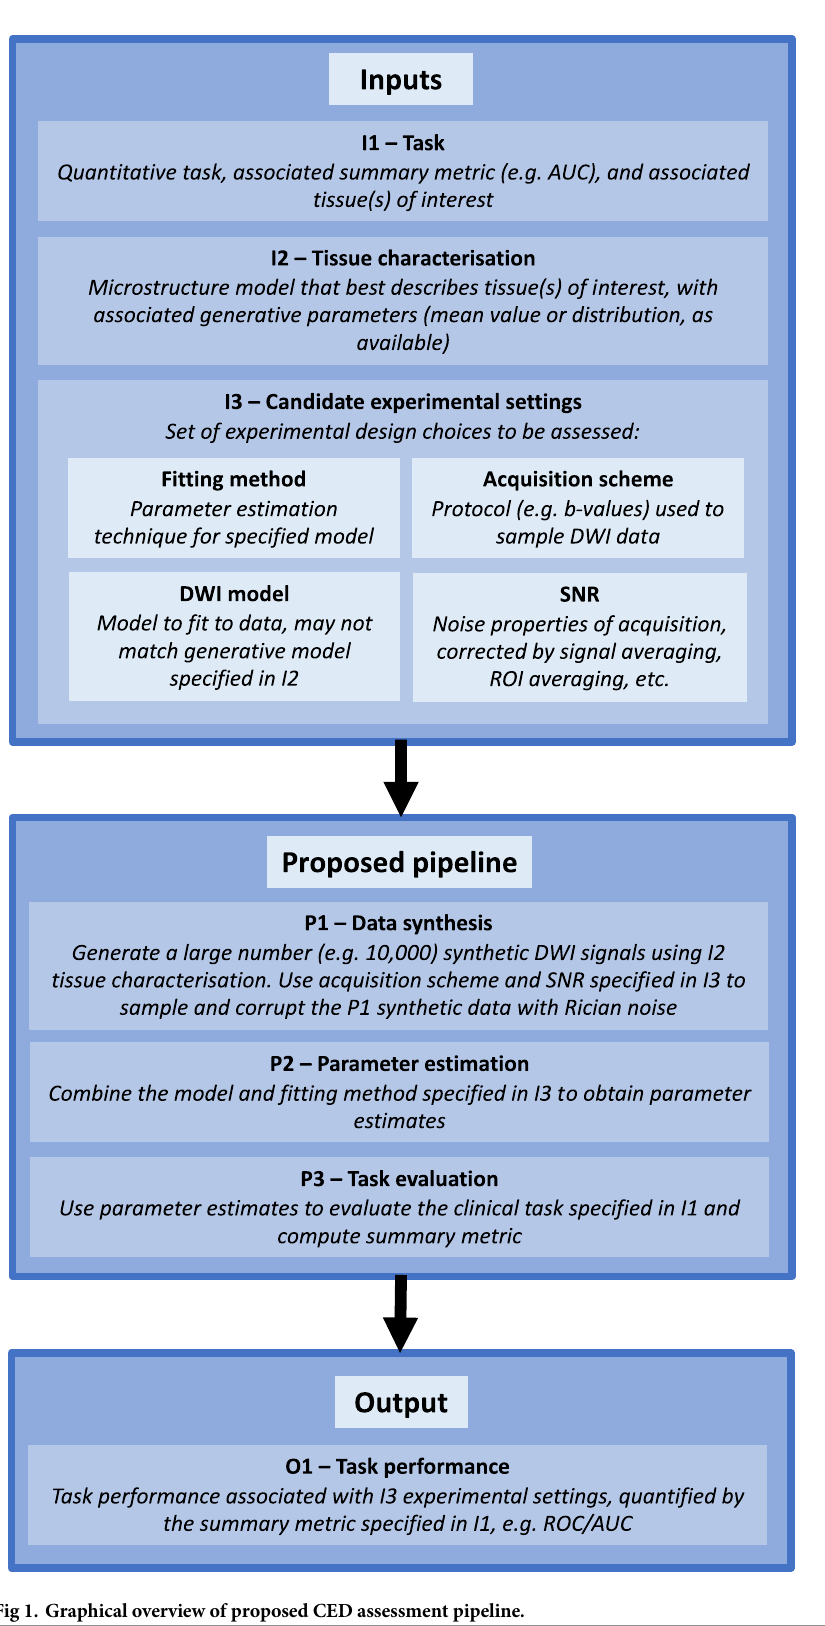
Fig 1. Graphical overview of proposed CED assessment